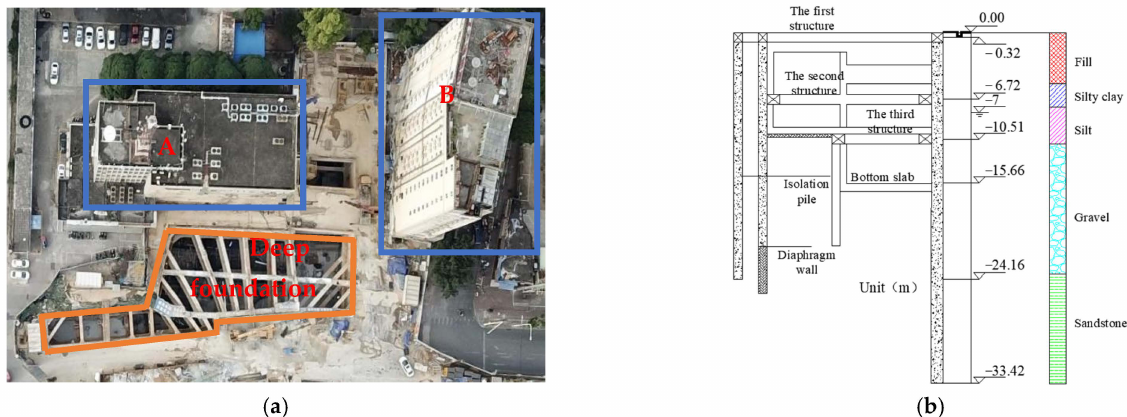
Figure 3. Deep foundation pit location and supporting structure profile. ( a ) Location of the deep foundation pit; ( b ) profile of the supporting